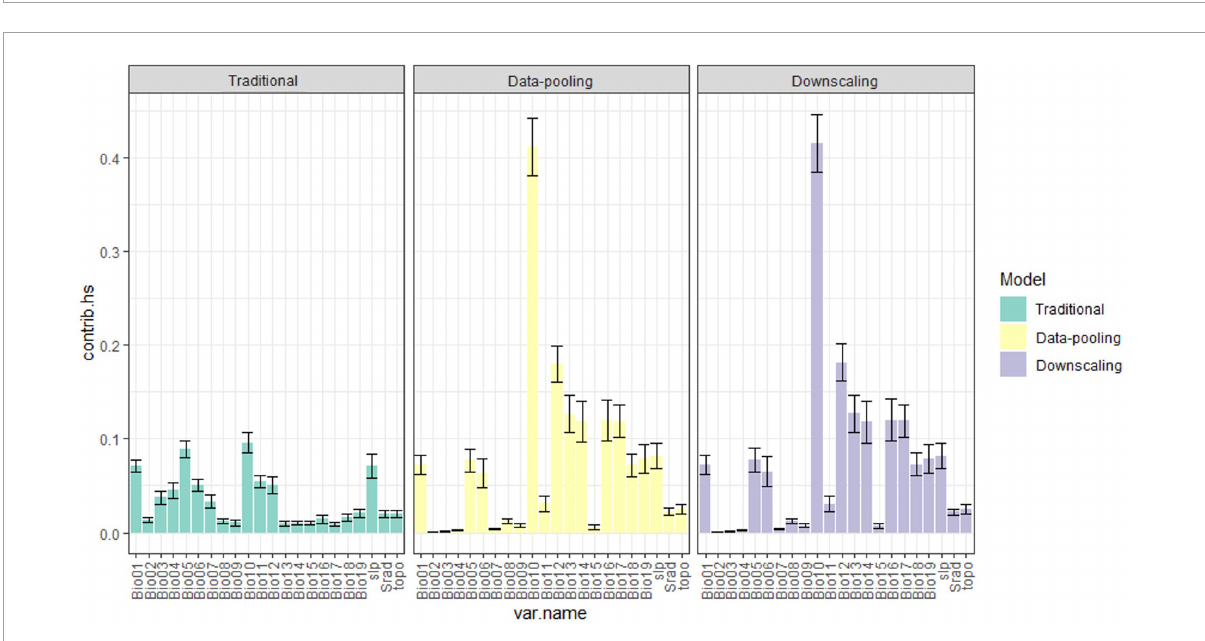
FIGURE2 Barplot representing the estimated variable importance under the different models. The height of each bar represents the average importance across species while the vertical black bar represents the associated standard error.